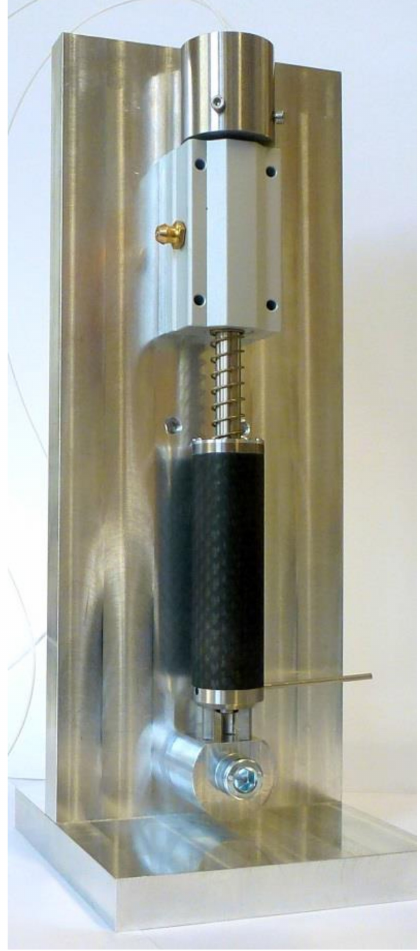
Figure 15. Test configuration of the laboratory